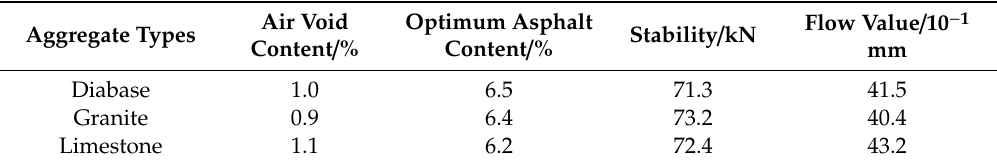
Table 8. Marshall test results for the three